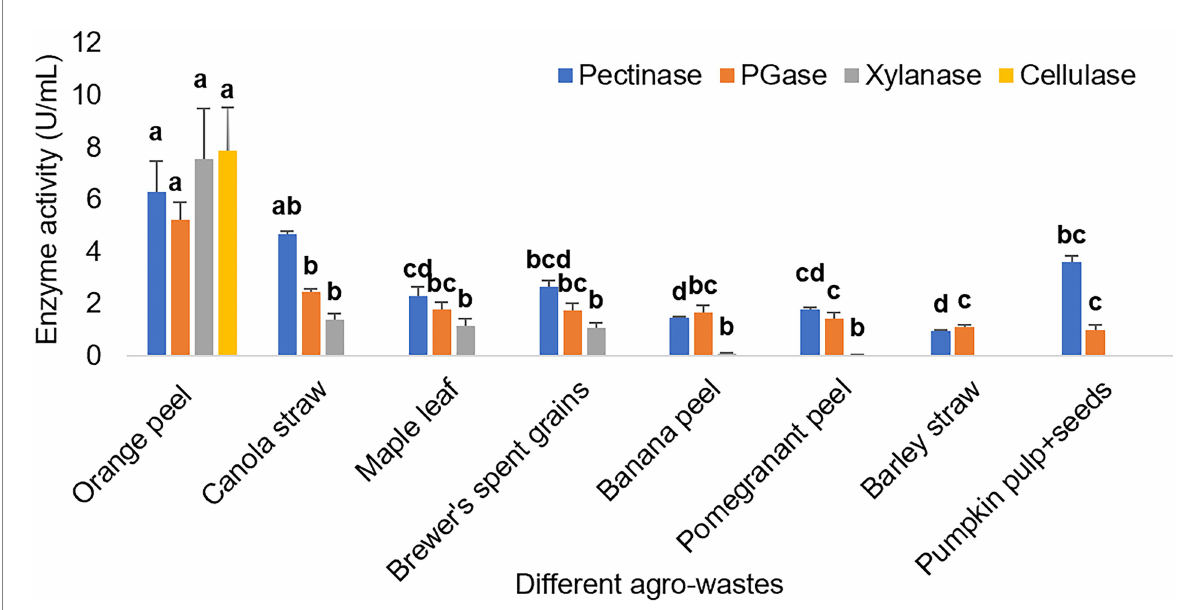
FIGURE 4 Different enzyme activities exhibited by Bacillus sp. using different agro-wastes as carbon sources. The bar represented the mean enzyme activity with the standard deviation error bar. Lowercase alphabets indicate that the values are statistically significant at p ≤